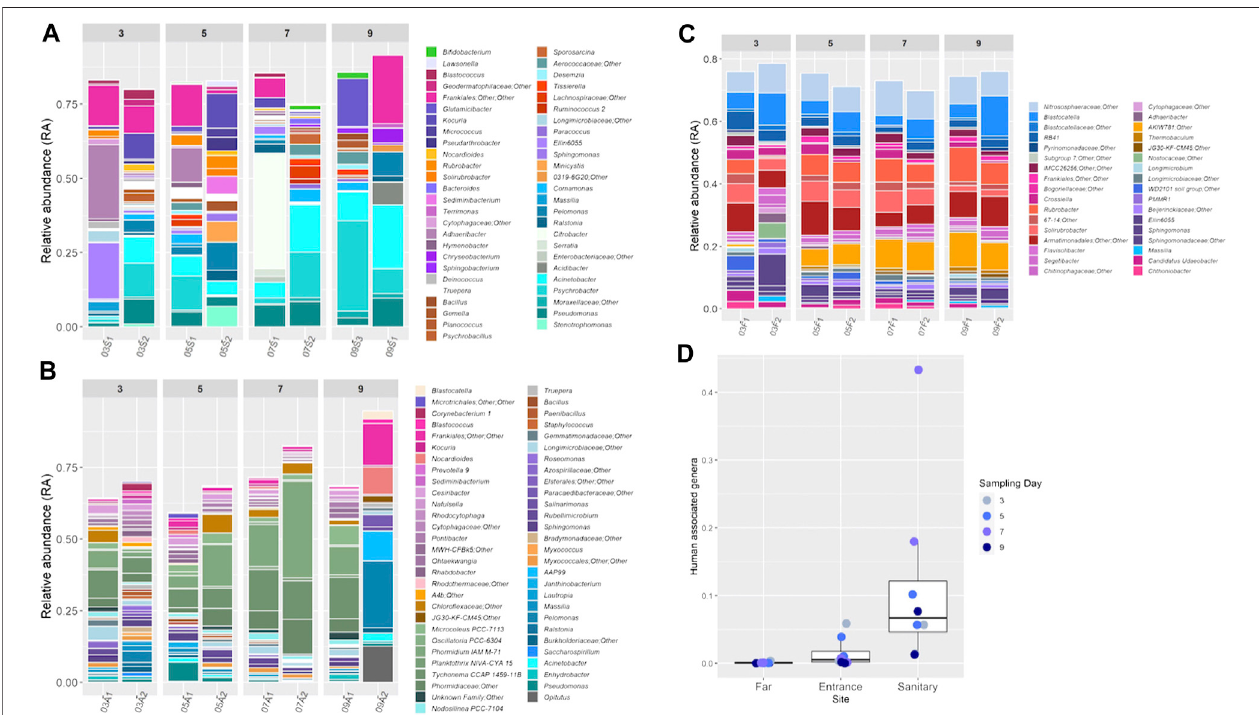
FIGURE3|(A – C) Relativeabundanceofbacterialgenerainthesoilsamplesduringthemission.EachcoloronthegraphrepresentsadistinctfamilylevelOTU.Only taxa that constituted > 1% of an individual sample are presented, unless stated otherwise. Bar plots were generated using R software. (D) RA of human associated genera in different sites during the mission. Colors denote the sampling